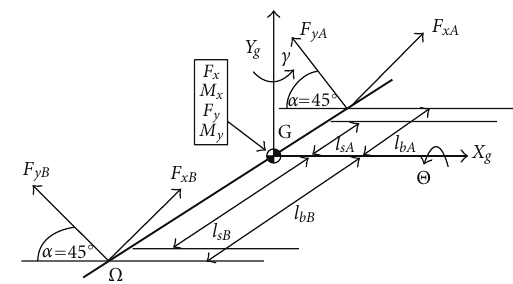
Figure 1: Schematic view of 4-axis rotating shaft supported by two radial active magnetic bearings with